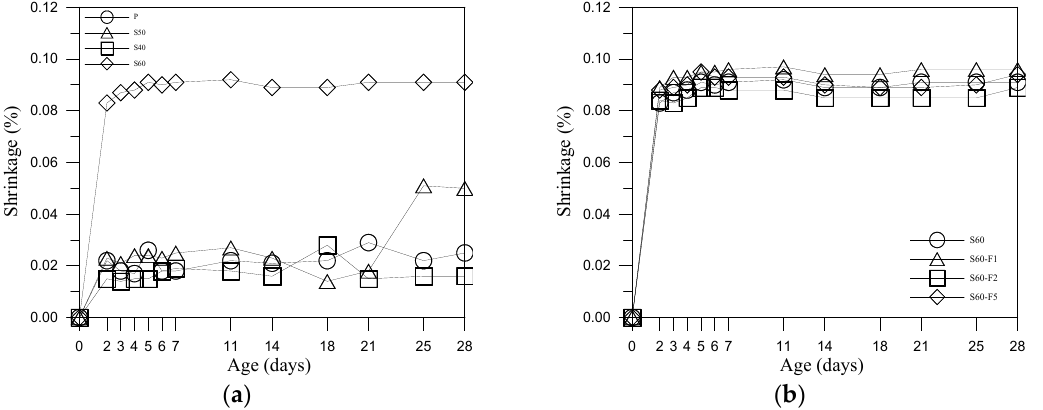
Figure 6. Length change results: ( a ) comparison to P, S40, S50 and S60 specimens and ( b ) comparison to S60, S60-F1, S60-F2 and S60-F5.